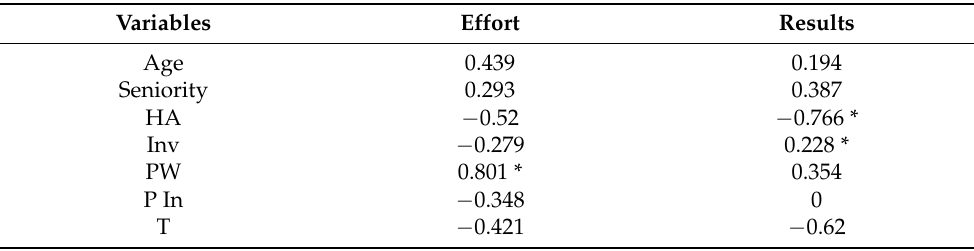
Table 12. Correlations between various variables associated with the group of auxiliary and non- teaching staff.